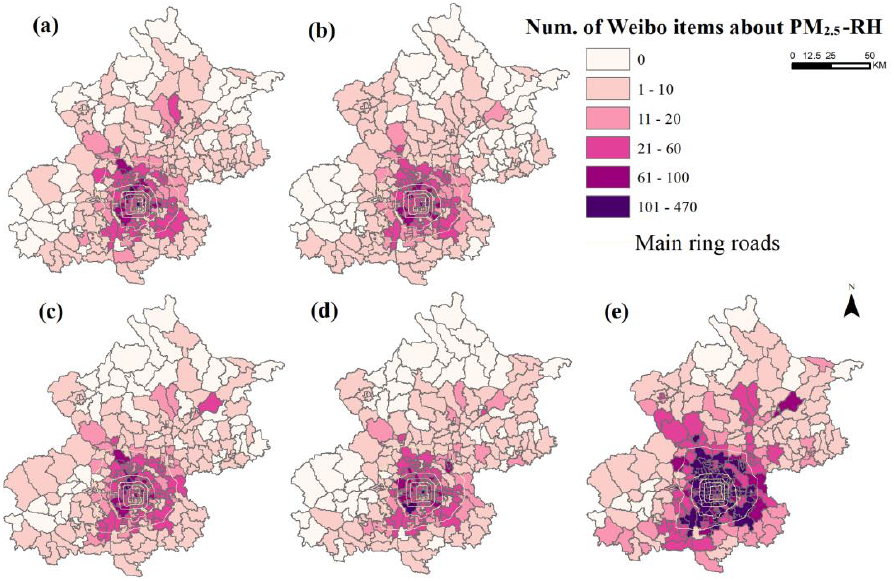
Figure 4. Spatiotemporal variations of PM 2.5 -RH in ( a ) Spring ( b ) Summer ( c ) Autumn ( d ) Winter, and ( e ) Annually. Note: PM 2.5 -related health (PM 2.5 -RH).